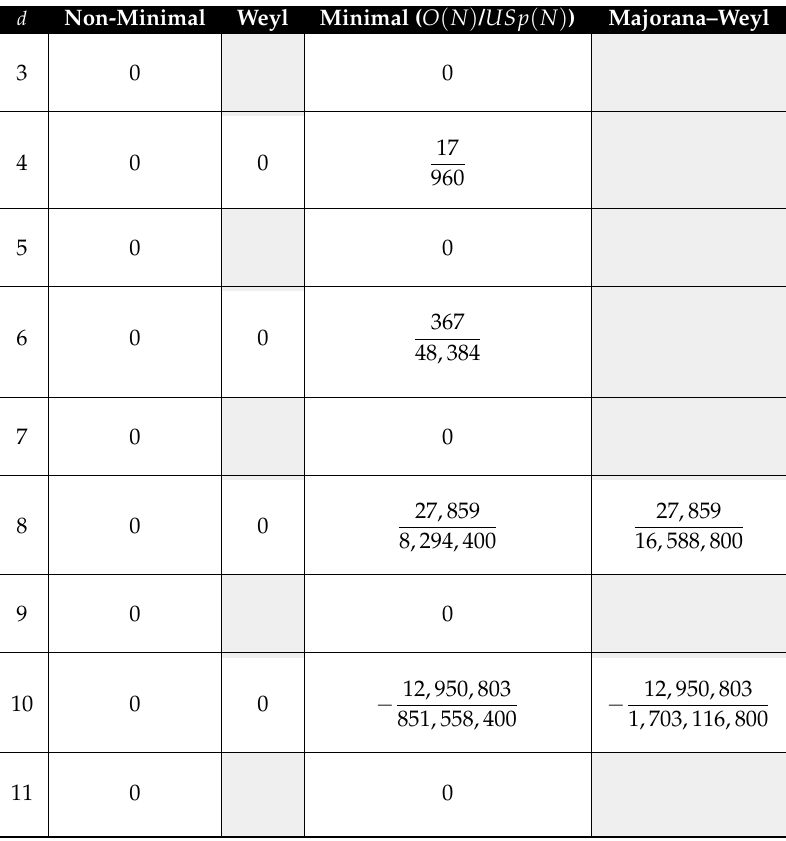
Table A1. Type B Casimir energies. The grey boxes indicate that the particular type of fermion is not defined for the given